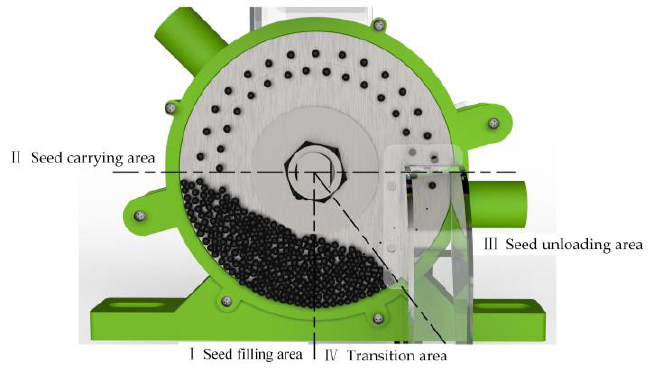
Figure 2. Diagrammatic representation of the working area division of the seed metering device.